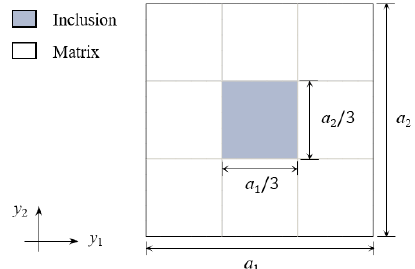
Figure 5. 2D unit cell with single inclusion.